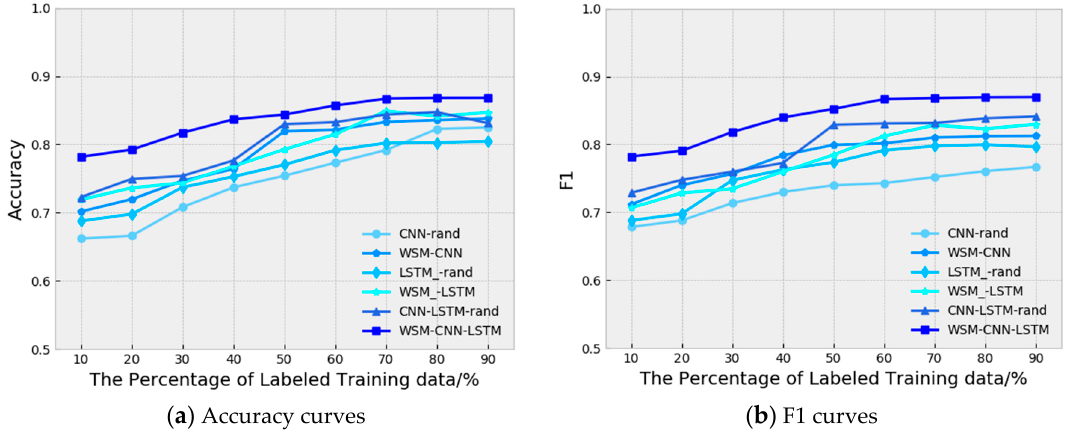
Figure 4. Impact of labeled training data size on each model.